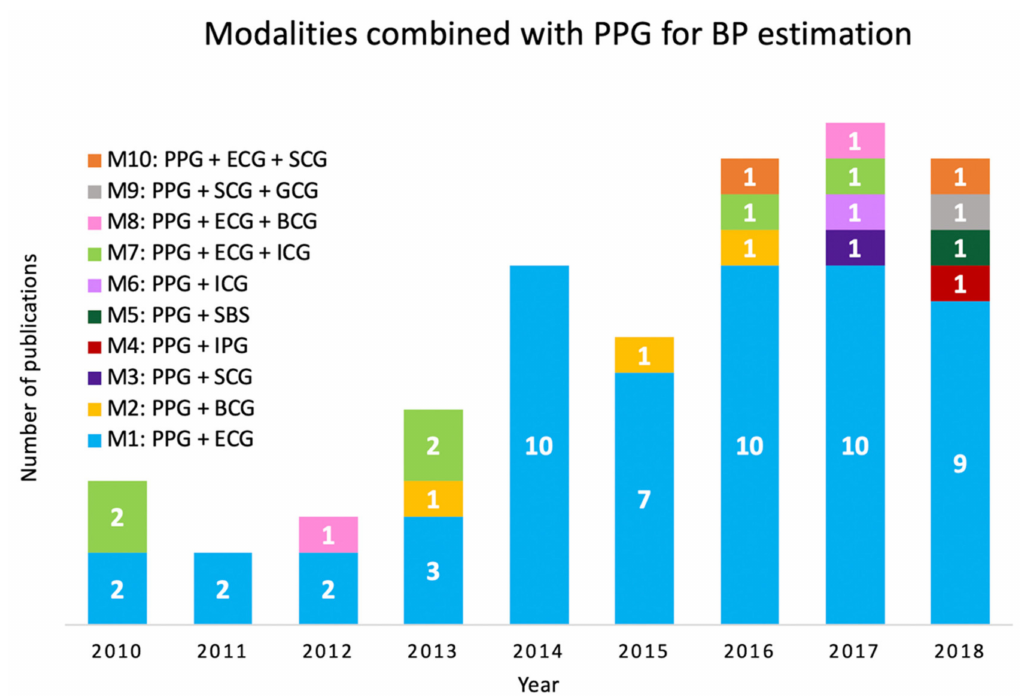
Figure 4. Number of publications per year and associated biosignal modalities that were combined with PPG from 2010–2019. M1-10: Various modality combinations of PPG: photoplethysmography with; ECG: electrocardiogram, SCG: seismocardiogram, BCG: ballistocardiogram, ICG: impedance cardiogram, GCG: gyrocardiogram, IPG: impedance plethysmography, and SBS: strain-based sensor. It can be observed that ECG is the dominant modality across all